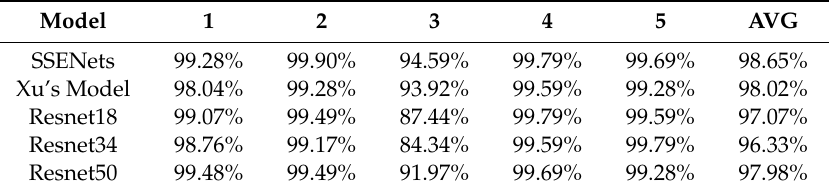
Table 8. The 5-fold cross-validation of training.